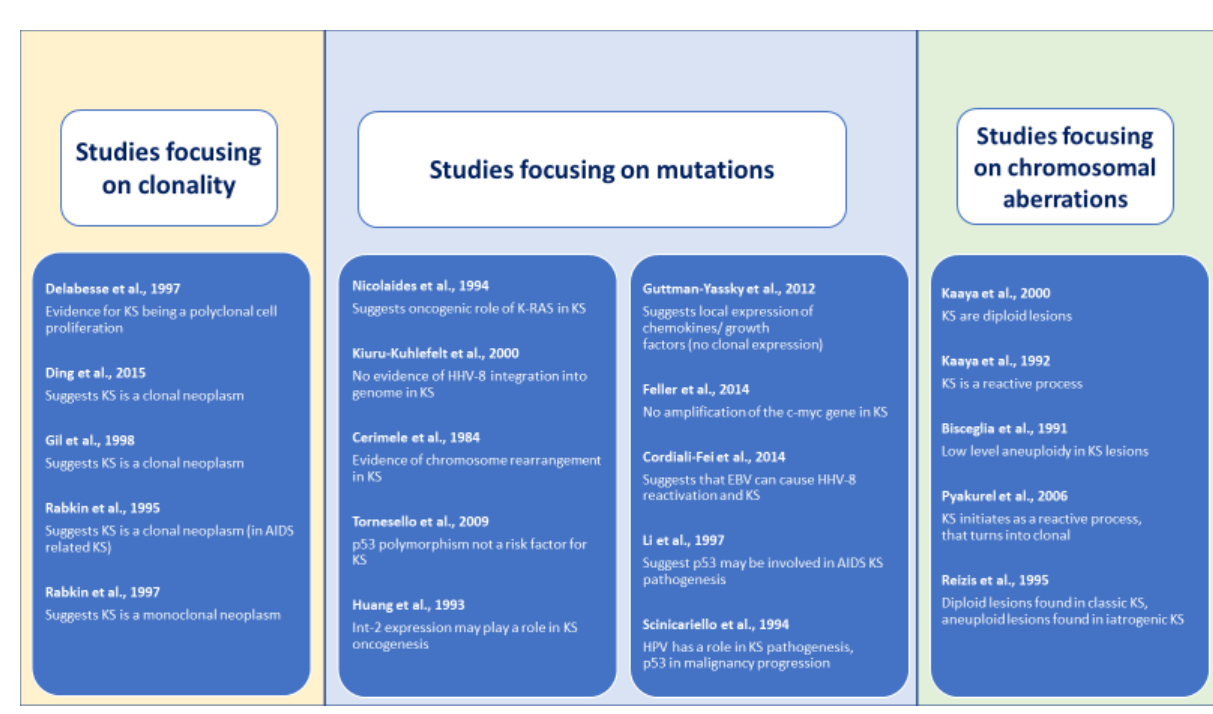
Figure 2. Outcomes of included studies assessing the neoplastic nature of Kaposi sarcoma.